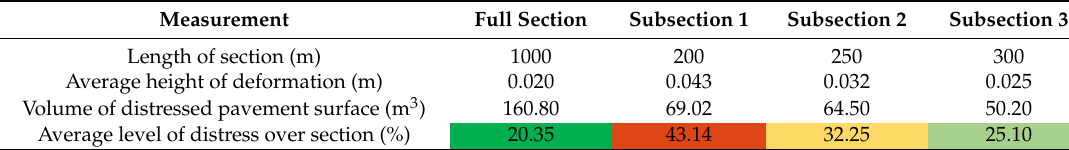
Table 5. Distress results of pavement models.